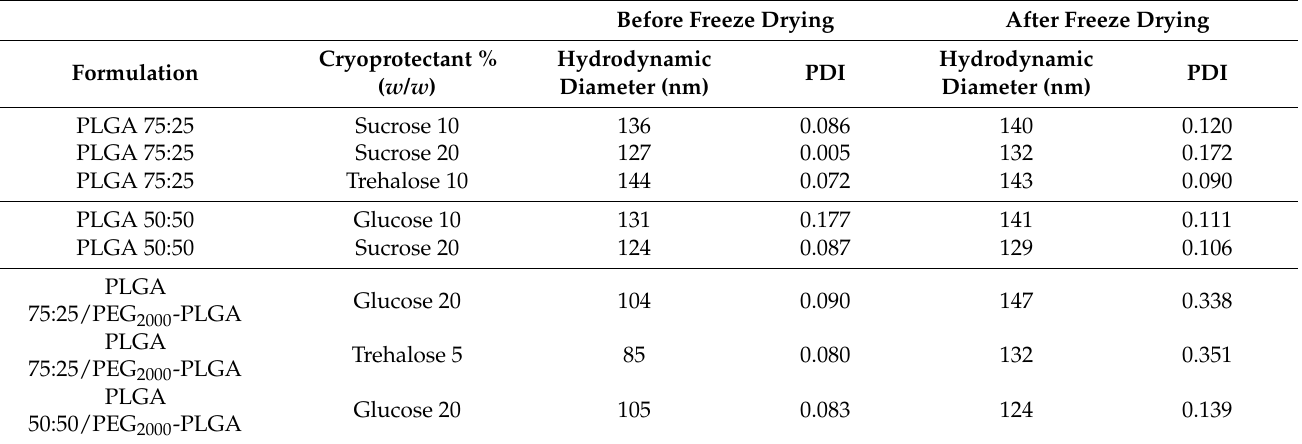
Table 1. Mean hydrodynamic diameter and PDI of PLGA formulations before and after the freeze- drying process ( n = 3). Before Freeze Drying After Freeze